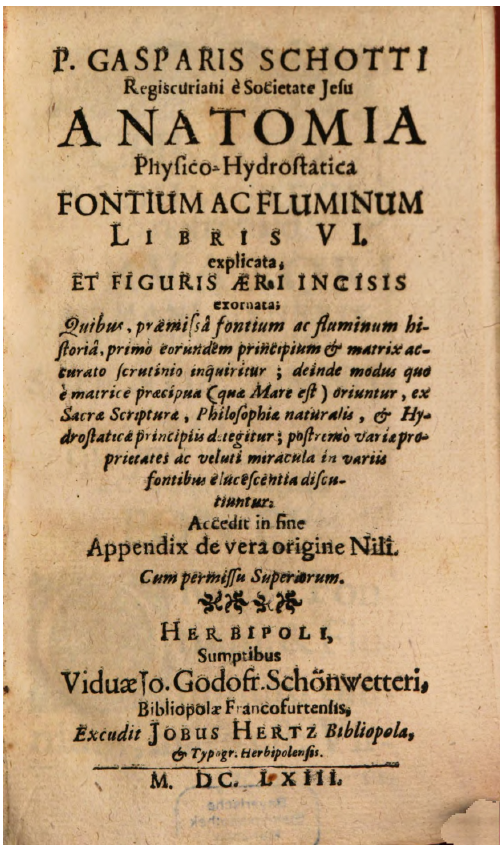
Figure 2. Front matter of Schott’s opus Anatomia physico– hydrostatica fontium ac fluminum (Schott, 1663, credits: Bay- erische Staatsbibliothek München, Phys.sp. 604 b, sheet 11,